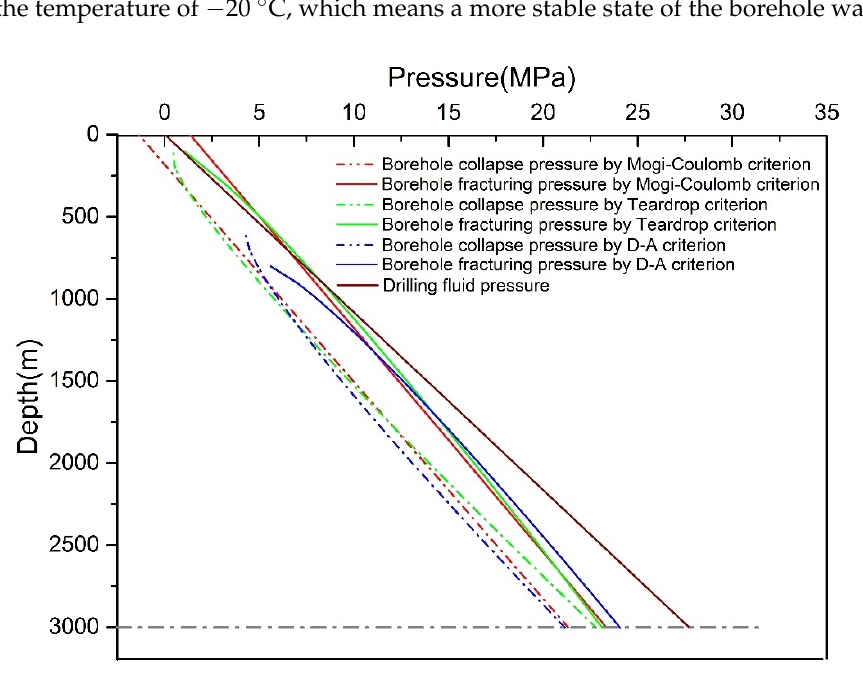
Figure 5. Critical borehole fracturing and collapse pressure considering three failure criteria ( d c = 0.823).